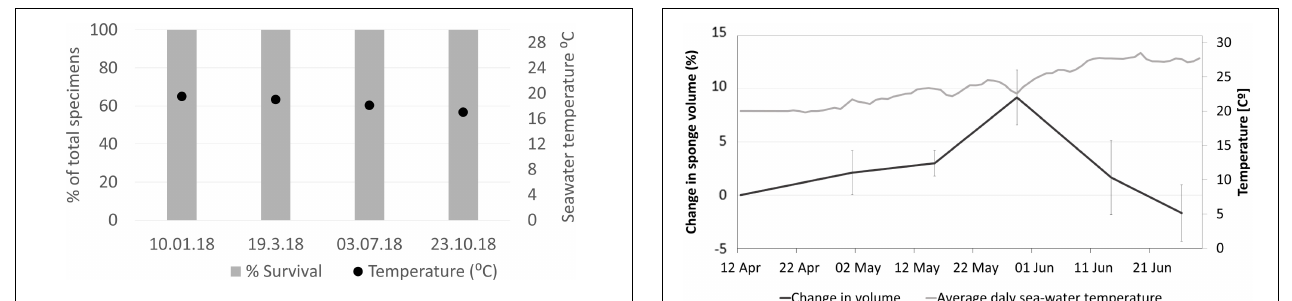
exposed to extreme temperature (Erwin et al., 2012;